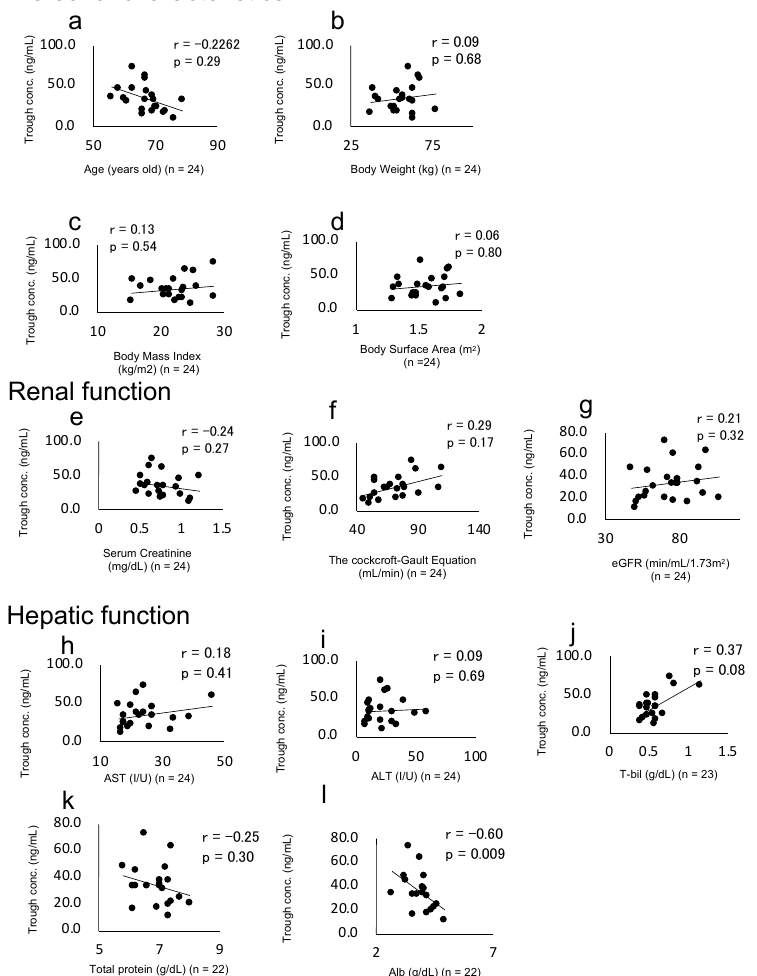
Figure 2. Correlation between the trough plasma concentration of afatinib and laboratory data (per- sonal parameters, renal function, and hepatic function). The r - and p- values provided above each graph represent Spearman’s rank correlation and the p -value, respectively. ( a ) Age. ( b ) Body weight. ( c ) Body mass index. ( d ) Body surface area. ( e ) Serum creatinine. ( f ) Cockcroft–Gault equation. ( g ) Estimated glomerular filtration rate. ( h ) Aspartate aminotransferase. ( i ) Alanine aminotransferase. ( j ) Total bilirubin. ( k ) Total protein. ( l ) Albumin. ( a – d ) Correlations between trough plasma concen- tration and personal characteristics. ( e – g ) Correlations between trough plasma concentration and renal function. ( h – l ) Correlations between trough plasma concentration and hepatic function.